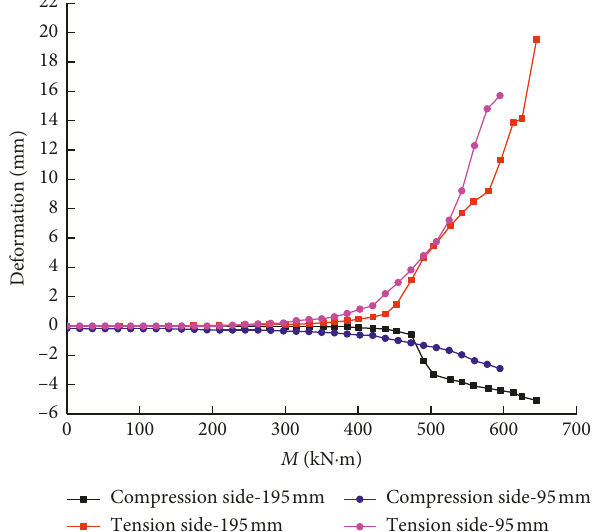
Figure 18: Comparison of experimentally observed joint deformations for different tenon